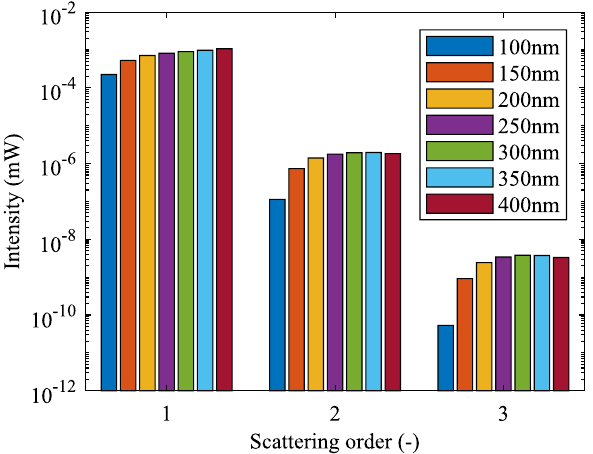
Figure 3. Light intensity under different scattering orders ( 1mW incident light).